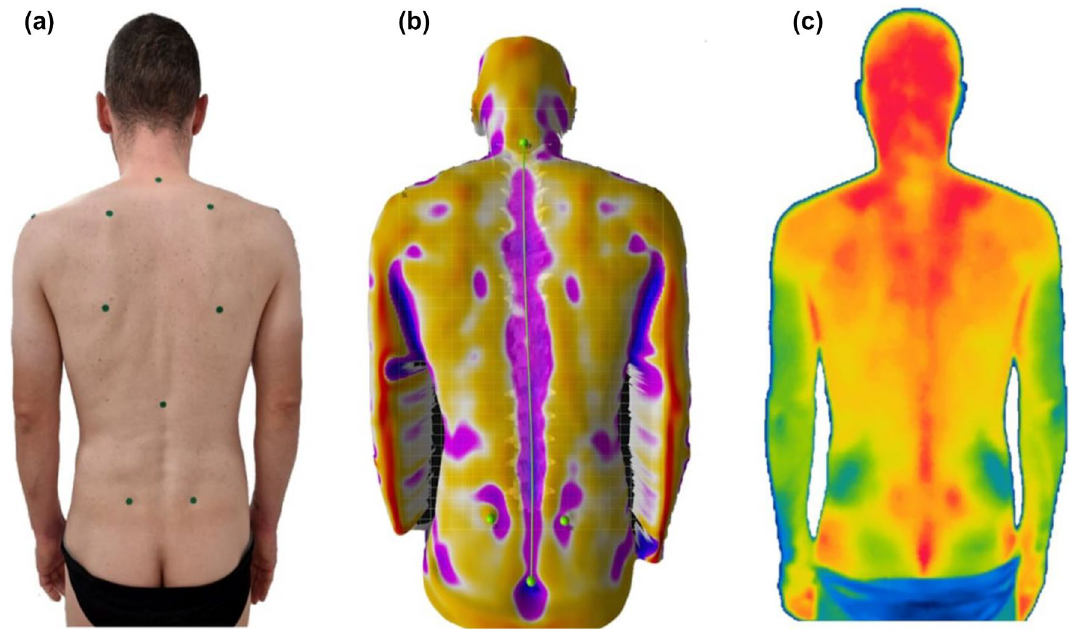
Figure 1. Combined infrared method representing a normal photo of the individual ( a ), a rasterstereographic representation ( b ) deriving from Spine 3D system, and infrared thermography ( c ) obtained from Thermal